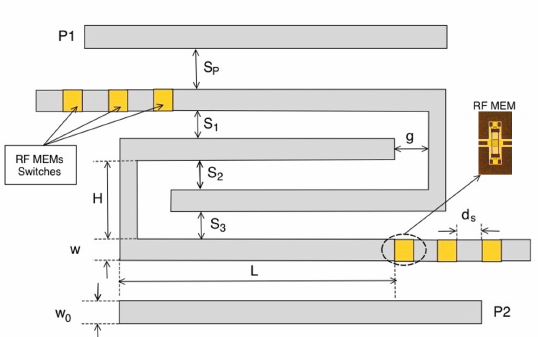
Figure 4. Pseudohairpin interdigitated reconfigurable filter equipped with RF-MEMS